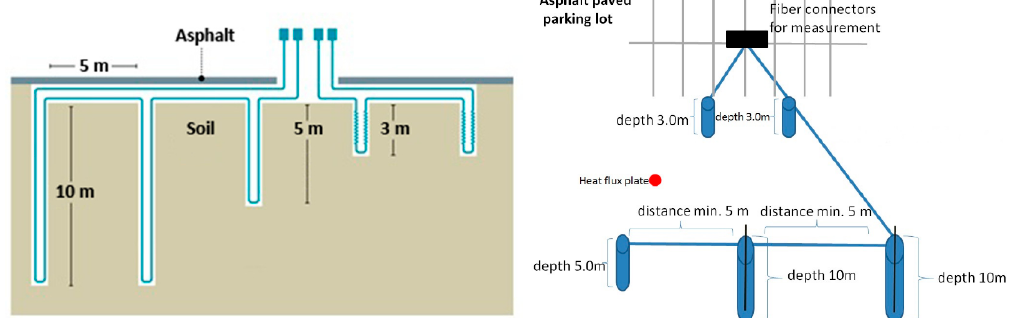
Figure 1. The measurement arrangements of the cables ( left ) and the geometrical positions of the holes ( right ) in the asphalt field. The same kind of independent measurement configuration was installed under the lawn.